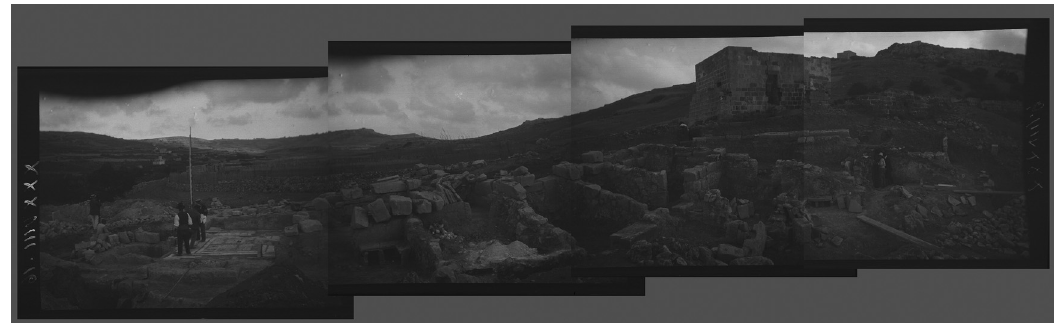
Figure 4: Four of Ashby ’ s photos stitched together to form a panoramic of the site ( Source: British school at Rome digital collection )